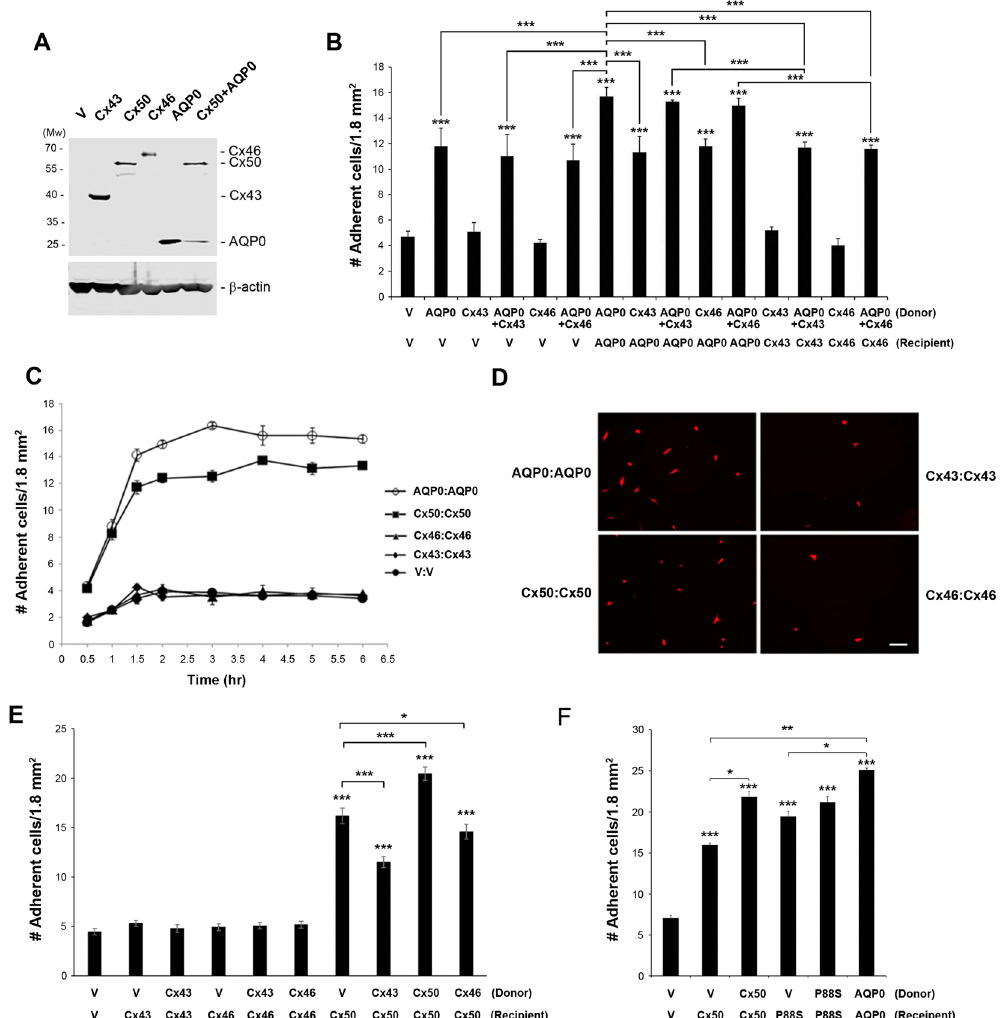
Figure 2. Cx50, not the other two lens connexins, Cx43 and Cx46, mediates cell-cell adhesion, and cell adhesion function is independent of Cx50 channel-forming function. Retroviruses containing RCAS(A) vehicle (V), Cx50, Cx46, Cx43 or AQP0 were used to infect CEF cells. ( A ) Crude membrane extracts of CEF cells expressing various connexins or/and AQP0 were immunoblotted with anti-Flag or β -actin antibody. ( B ) Cell- cell adhesion assay was conducted with donor or recipient cells expressing various combinations of connexins and AQP0. After 1.5 hr incubation, adherent cells were counted and quantified. ( C ) Cell adhesion assay was performed in CEF cells homotypic expressing AQP0, Cx50, Cx43, Cx46 or vehicle (V) control after various time periods of incubation. Adherent cells were counted and quantified. ( D ) Representative fluorescence images of adherent cells are shown in red fluorescence. Bar, 50 µ m. ( E ) Cell adhesion assay was performed in CEF cells expressing lens connexins or vehicles (V) homotypic or heterotypic. ( F ) High titter recombinant retroviruses containing RCAS(A) vehicle (V), Cx50, Cx50P88S mutant or AQP0 were used to infect CEF cells. Cell adhesion assay was conducted and adherent cells were counted and quantified. The data are presented as the mean ± SEM. n = 3. As compared to vehicle (V) controls or otherwise indicated, * P < 0.05; ** P < 0.01; *** P <